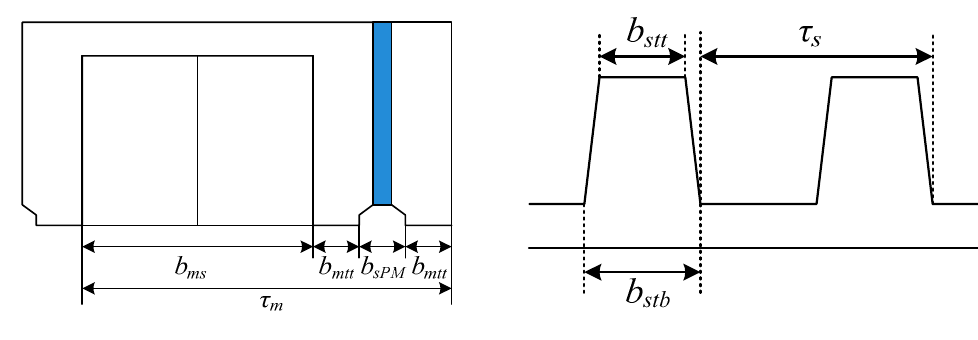
Figure 7. Definition of key parameters.